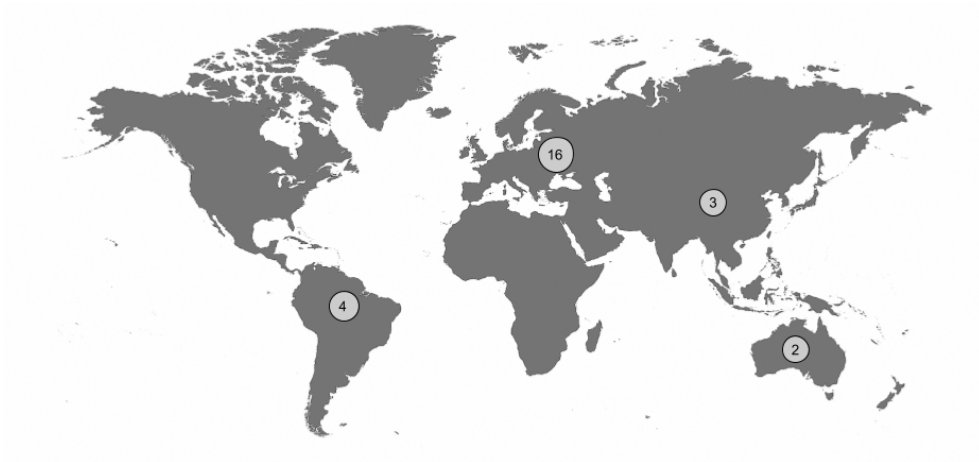
Figure 5. World map with number of studies from each